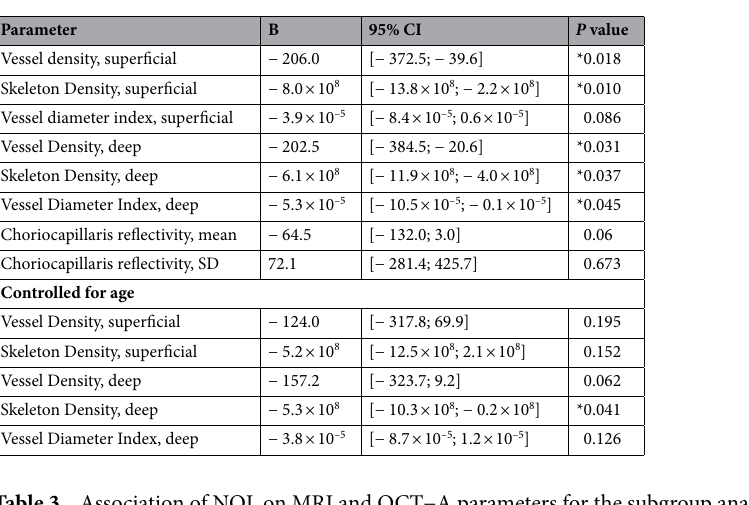
Table 3. Association of NOL on MRI and OCT−A parameters for the subgroup analysis of cases in multiple linear logistic regression analysis. NOL, number of white matter hyperintensity lesions on magnet resonance imaging; SD, standard deviation. The numbers are marked with asterisks to highlight statistical significance.